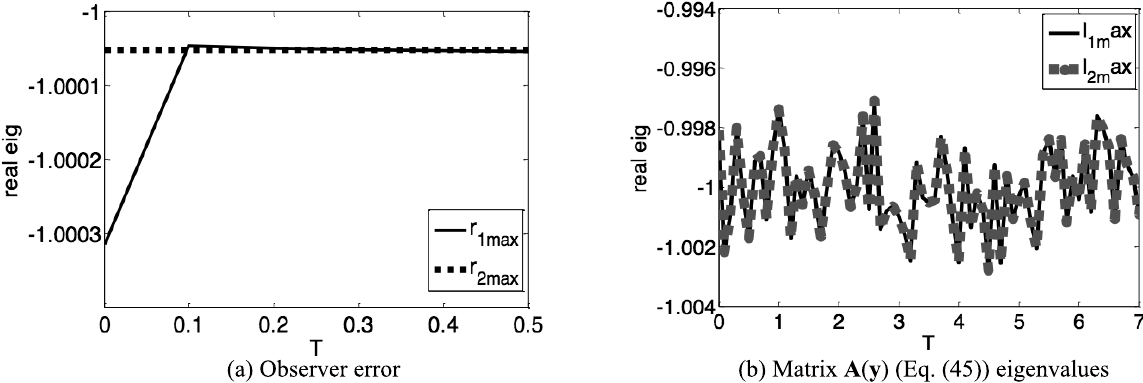
Fig. 7. State observer design with parametric